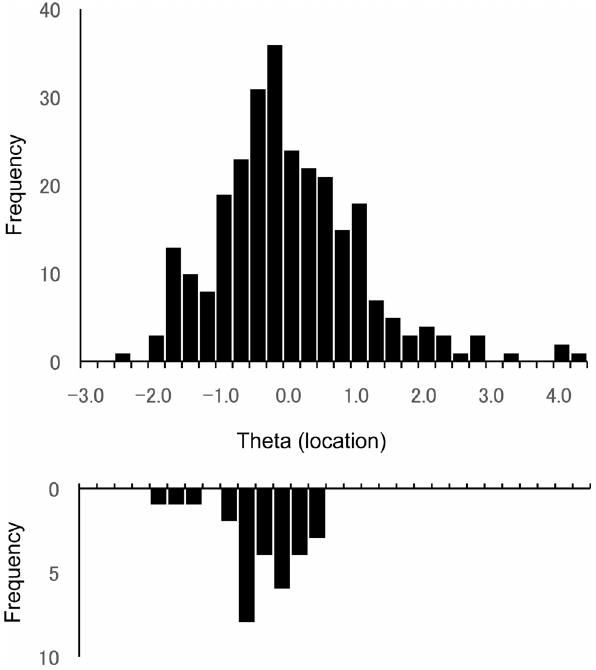
Figure 1. Targeting of item thresholds with regard to the patients in this study. The Figure shows locations of the patients (above) and of the item thresholds (below) on the same scale, in units of the latent trait.